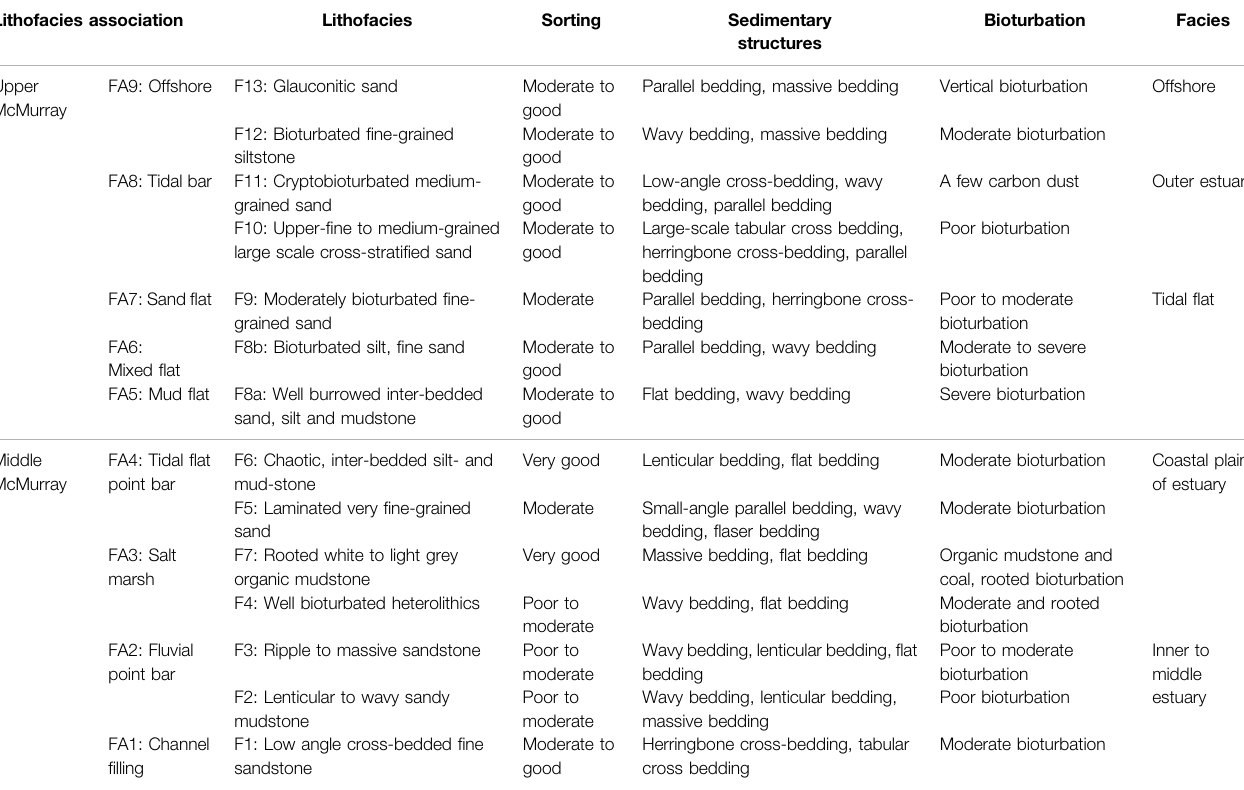
TABLE 1 | Lithofacies classi fi cation scheme for the interval of interest in the study area of the Athabasca block. Lithofacies